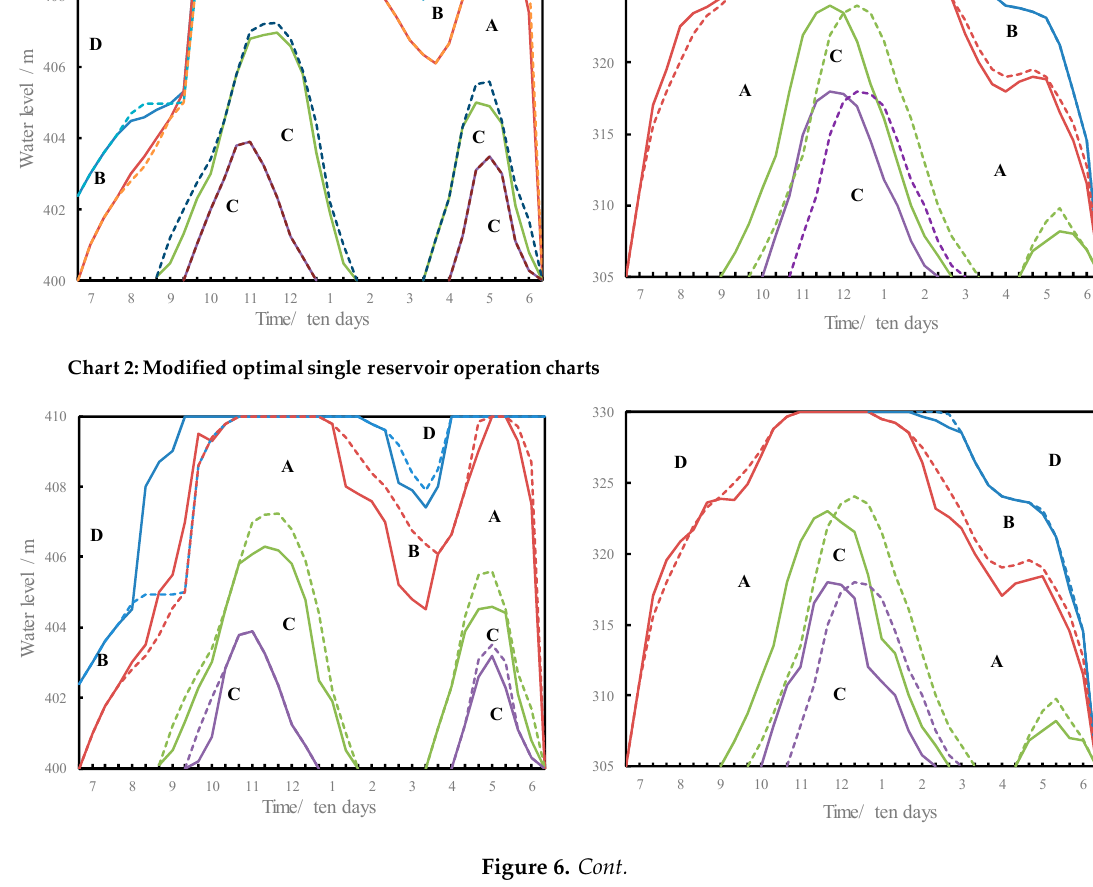
Chart 3: Modified optimal cascade reservoirs operation